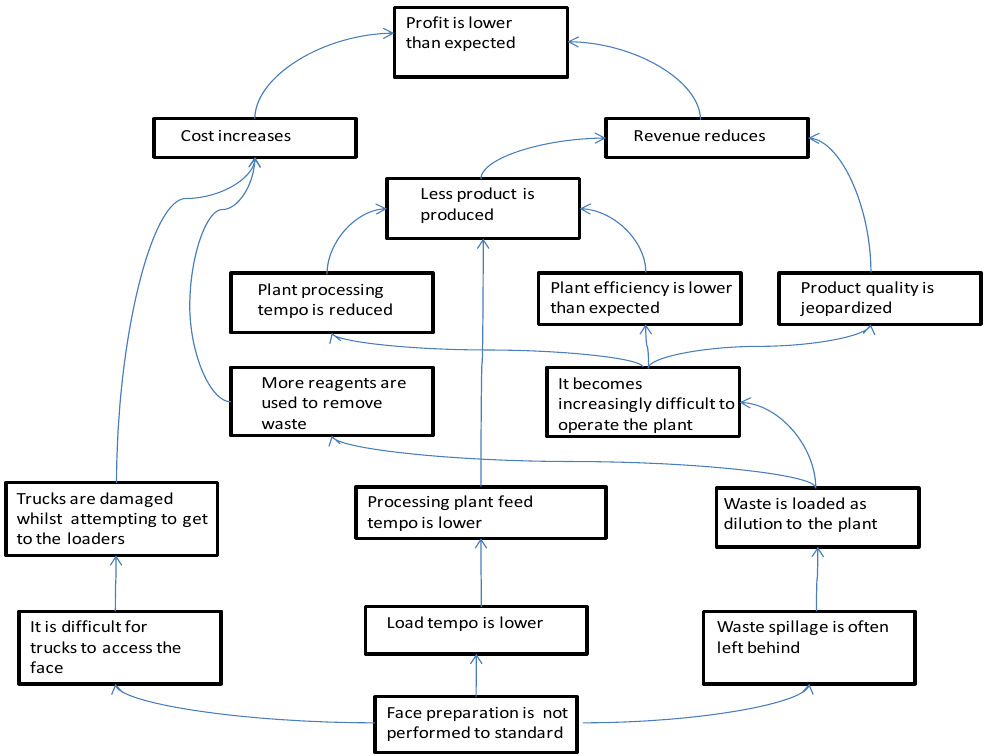
Figure 2: Cause–and-effect diagram illustrating the adverse effects that inadequate face preparation can have on the overall performance of an opencast mine Figure 2 aims to indicate that a lack of proper face preparation can lead to lower production rates, lower process efficiencies, lower maintenance availability, increased cost and lower profitability. In fact, inadequate face preparation can render a mining system unstable and